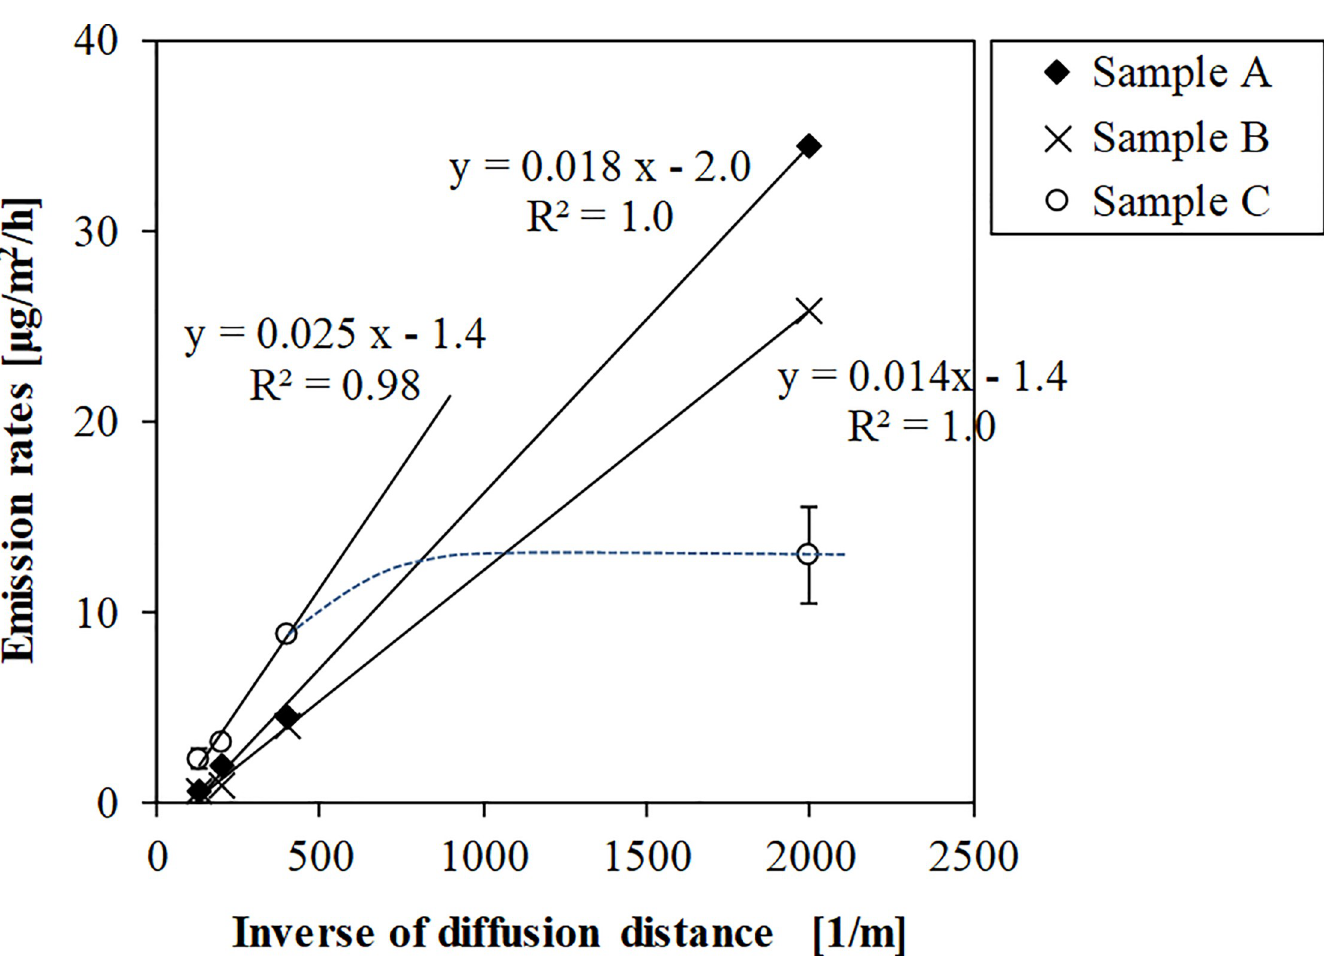
Fig 4. DEHP emission rates from samples A, B, and C measured using PFS vs. inverse of diffusion